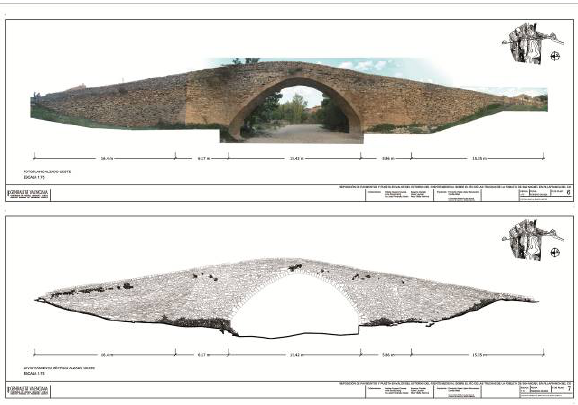
Fig. 1. Manual survey + photography: Elevation of the bridge at